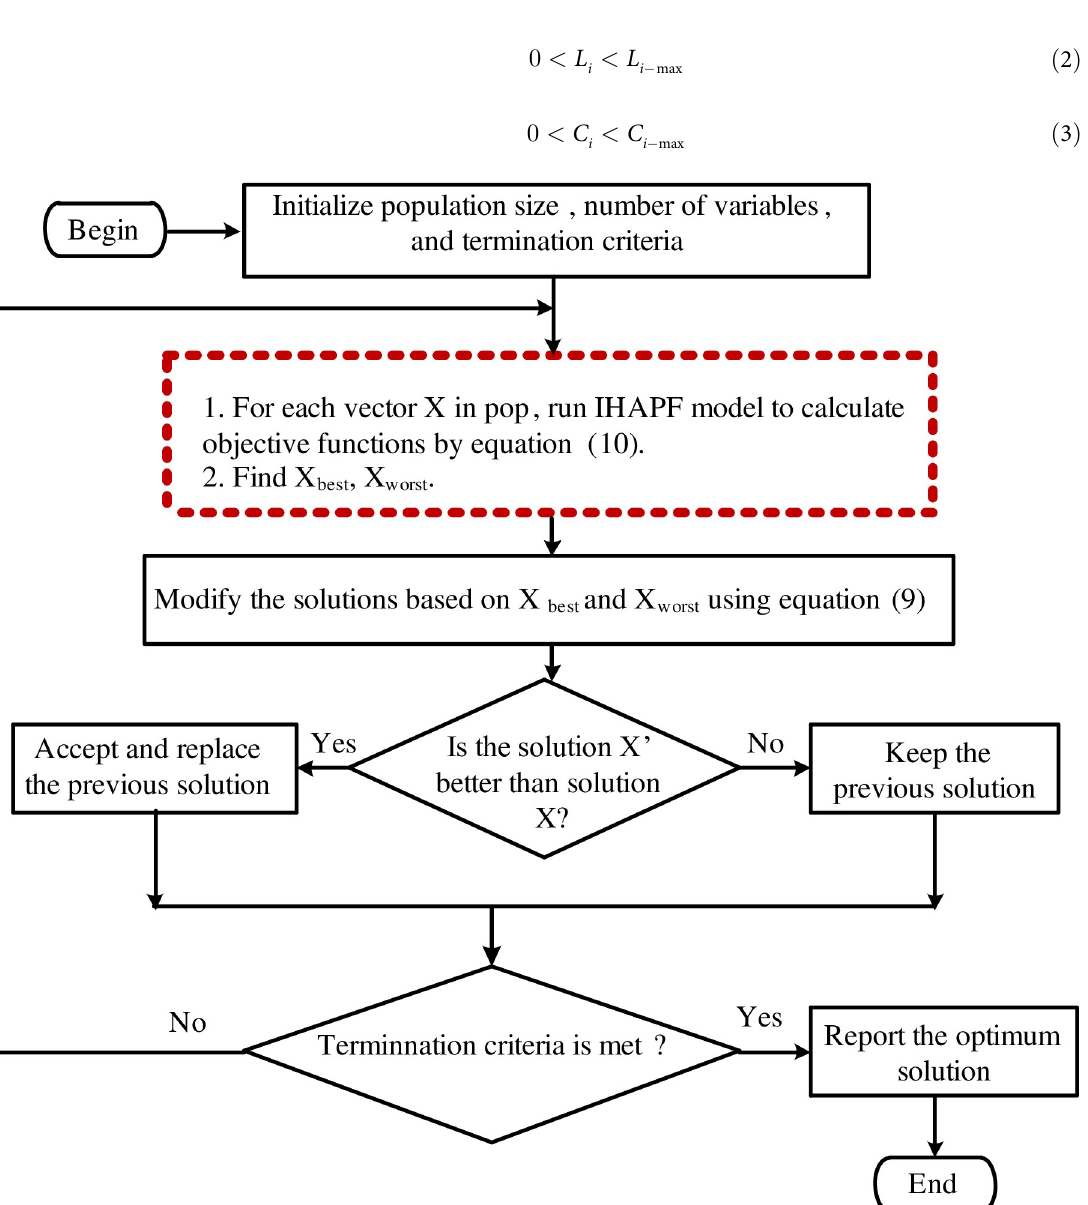
Fig 3. Flowchart for parameters calculation design for IHAPF using Jaya